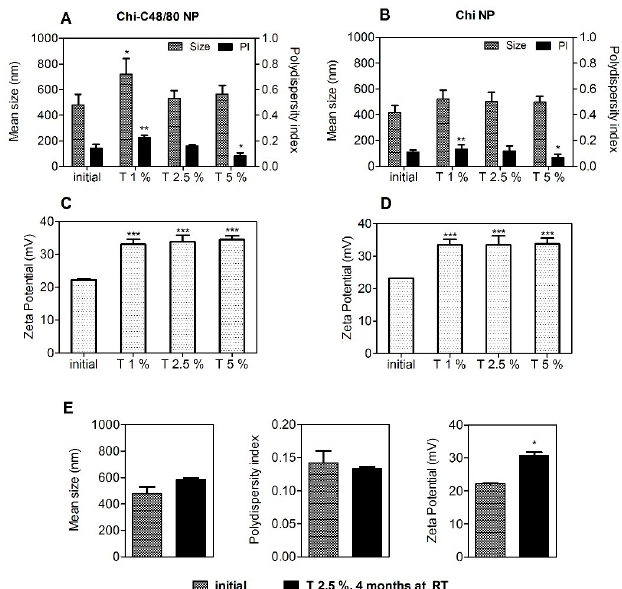
Figure 5. Effect of lyophilization with different concentrations of trehalose on the characteristics of nanoparticles. Size, polydispersion index, and zeta potential of Chi-C48/80 NPs ( A , C ) and Chi NPs ( B , D ) were measured before and after liophilization with 1%, 2.5%, and 5% of trehalose. ( E ) To evaluate the long-term stability of the lyophilized nanoparticles, Chi-C48/80 NPs plus 2.5% of trehalose were characterized after 4 months at room temperature (RT). Data are expressed as mean ± SD, n = 3.